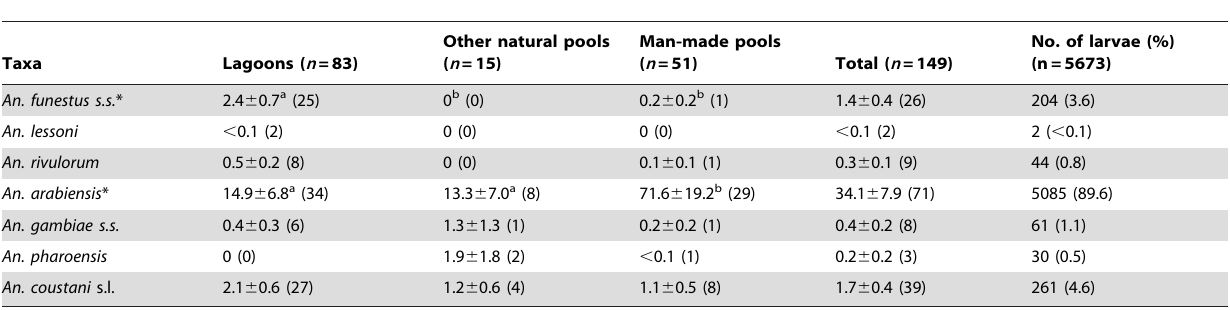
Table 4. Mean density 6 SE (per site) and occurrences of anopheline larvae sampled from each type of water pool in 2009.